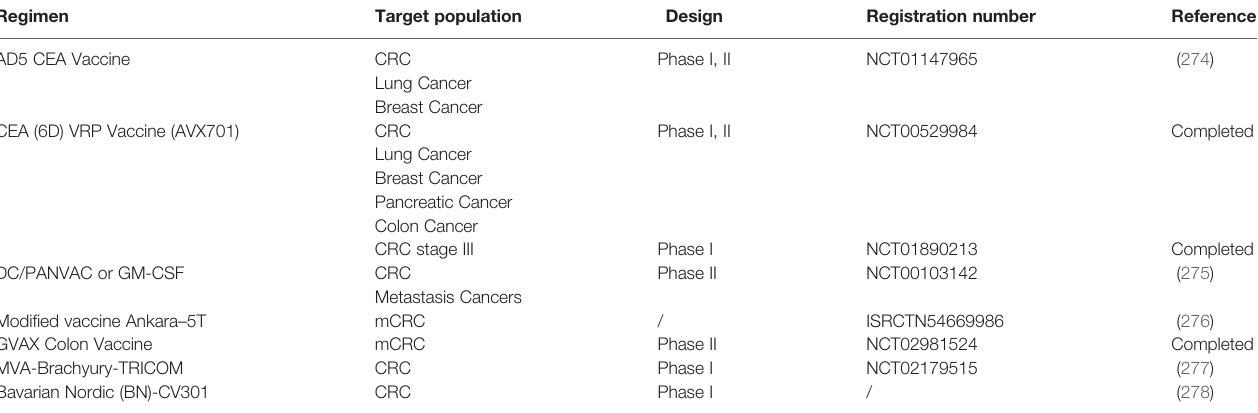
TABLE 5 | Summary of cancer vaccine and oncolytic virus therapies for colorectal cancer (CRC). Regimen Target